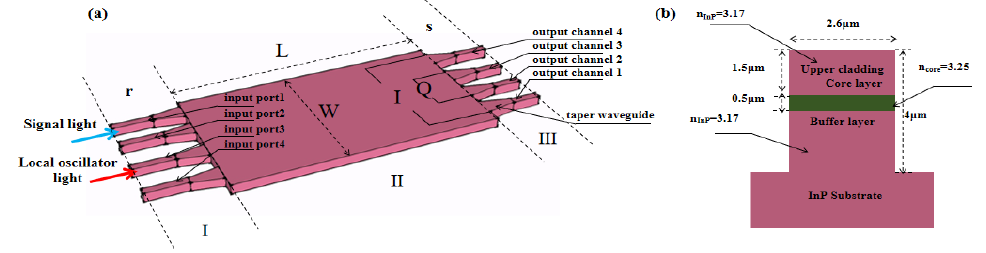
Figure 1. ( a ) The three-dimensional (3D) stereogram of the 90 ◦ hybrid structure and ( b ) the cross-section of the waveguide structure.